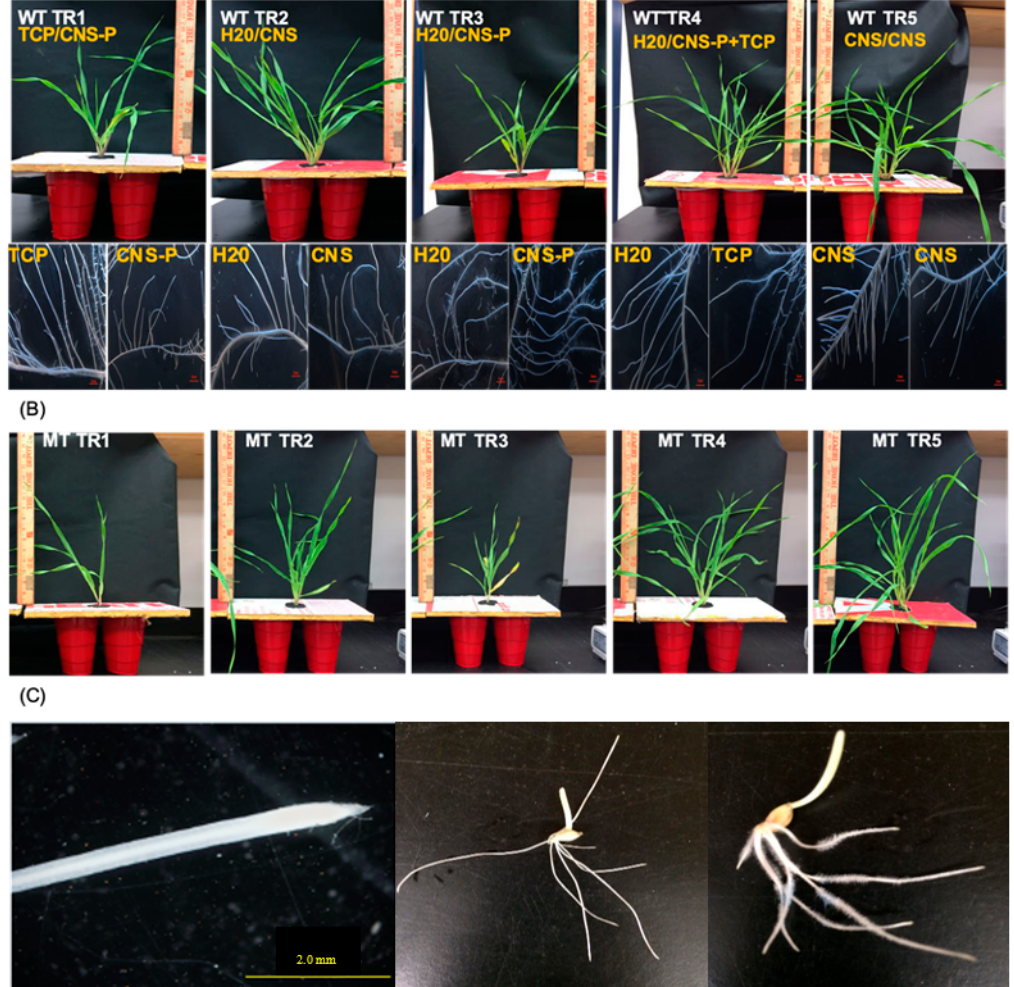
Figure 2. Images taken at 24 DAT of plant sizes and root of the five treatments of wide type ( A ) and seedling of the mutant ( B ) and mutant root ( C )—left: taken at 24 DAT with a microscope camera, one single root with a 2.0 mm scale; middle: taken with a regular camera, a mutant seedling without any root hair; right: taken with a regular camera, a wide type seedling with prolific root hairs.